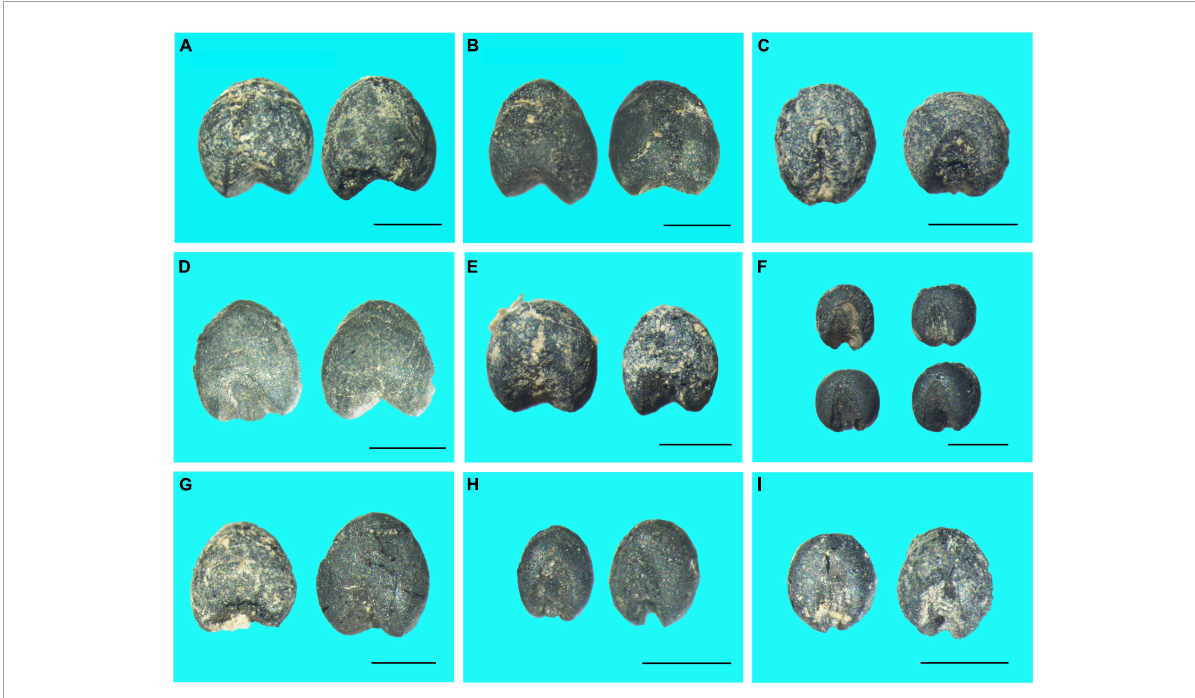
FIGURE3 Photographs of charred crop remains unearthed from different periods at the Gedachuan site. (A–C) Banpo Phase. (D–F) Miaodigou Phase. (G–I) Qijia Culture. (A,B,D,E,G) Broomcorn millet. (C,F,H,I) Foxtail millet. (Scalebar: 1